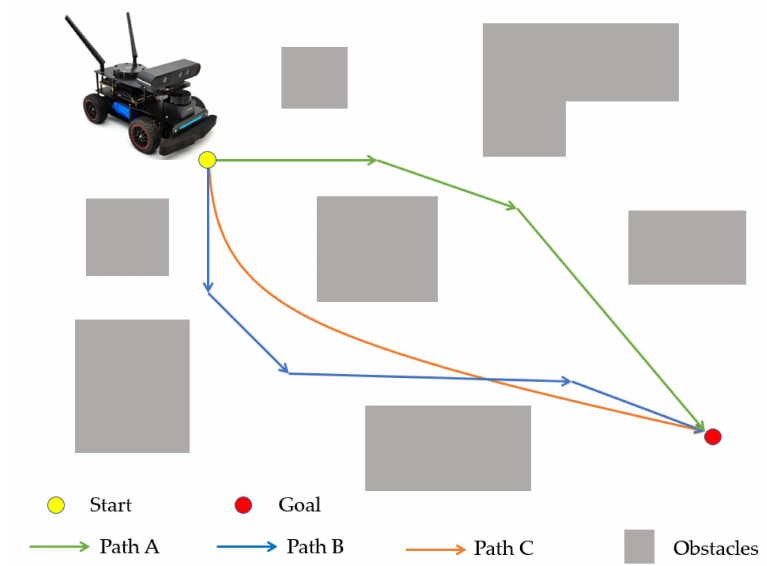
Figure 1. Path planning